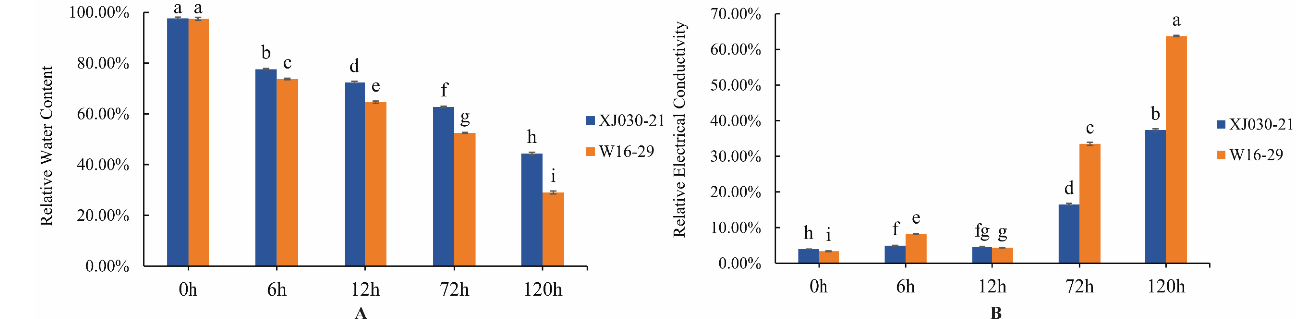
Figure 1. Related physiological indicators of drought-tolerant (X) and drought-sensitive (W) geno- types. ( A ): Relative water content (RWC). ( B ): Relative electrical conductivity (REC). Different lower-case letters in the figure indicate significant difference at level of p < 0.05.